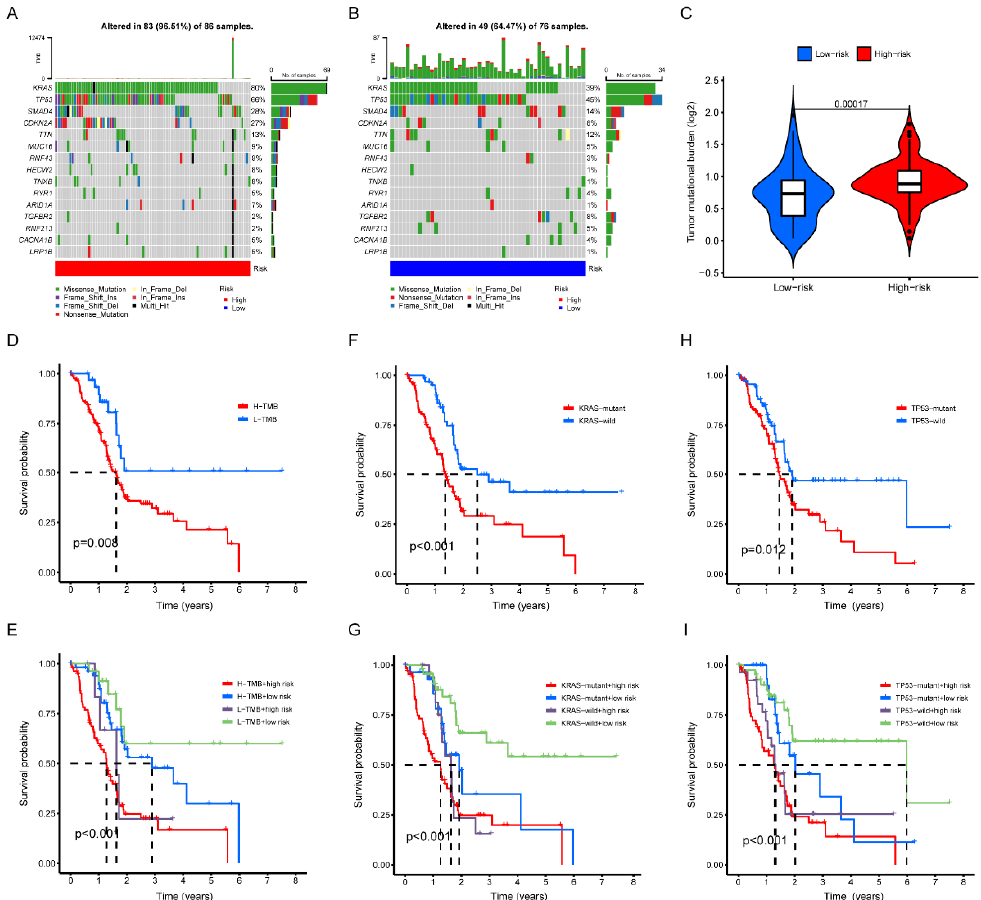
Figure 7. Correlation of Risk Prognosis Signature with Tumor Mutational Burden. ( A , B ) The waterfall plots of mutant genes in high- and low-risk groups. ( C ) The Violin plot of TMB score in high- and low-risk groups. ( D ) Kaplan–Meier survival curve of high-TMB and low-TMB. ( E ) Kaplan–Meier survival curve stratified by risk score and TMB. ( F ) Kaplan–Meier survival curve of KRAS -mutant and KRAS -wild. ( G ) Kaplan–Meier survival curve stratified by risk score and KRAS . ( H ) Kaplan–Meier survival curve of TP53 -mutant and TP53 -wild. ( I ) Kaplan–Meier survival curve stratified by risk score and TP53 .